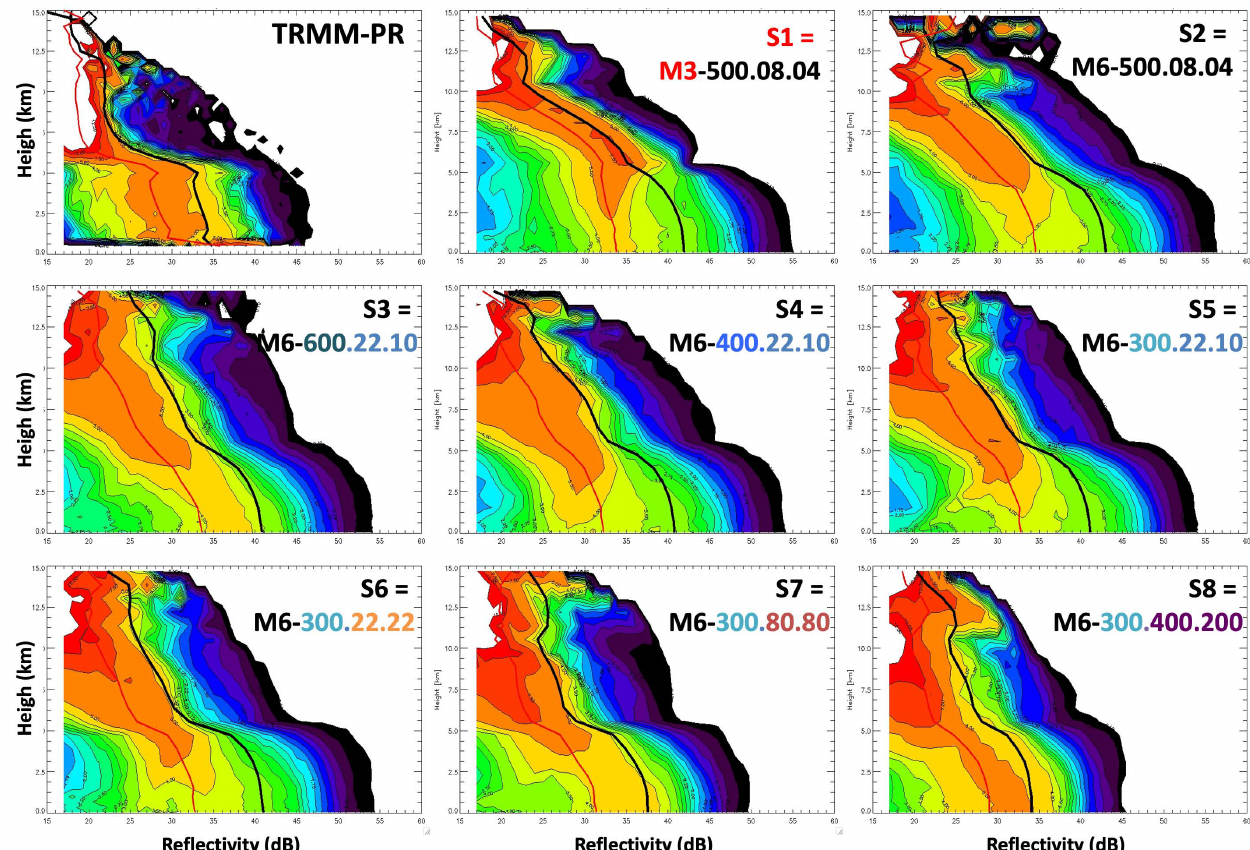
Figure 11. Comparing synthetic and observed Contoured Frequency by Altitude (CFADs). The mean and the mode of the distributions are shown with the heavy red and black curves. The observations, and the eight different experiments, are arranged in the same order as in Figure